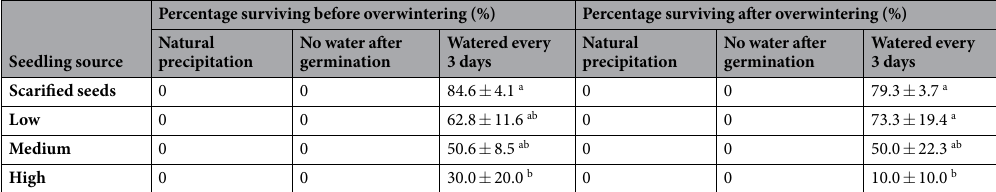
Table 2. Percentage (mean ± se) before and after overwintering survival of seedlings from scarified and the three predation classes of Astragalus lehmannianus seeds. Different superscript letters within a column indicate significant differences ( P < 0.05). Only one nonscarified seed germinated (in natural precipitation), and the seedling died soon after germination.